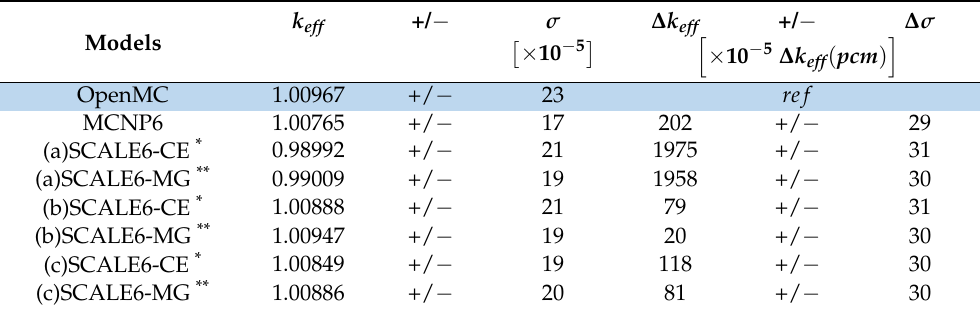
Table 2. Composition of k ef f results. OpenMC, MCNP6, and SCALE6. MCNP6 and SCALE6 k ef f data were obtained from references [12] and [13], respectively.